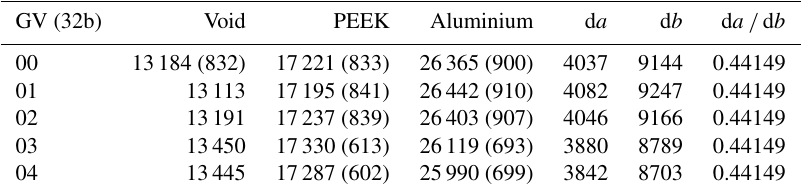
Table A1. Measured (normal font) and calculated (bold font) mean grey values (and standard deviation/error in the parentheses) of the parts of the scan that are not expected to vary in density with time for the normalisation of the images.